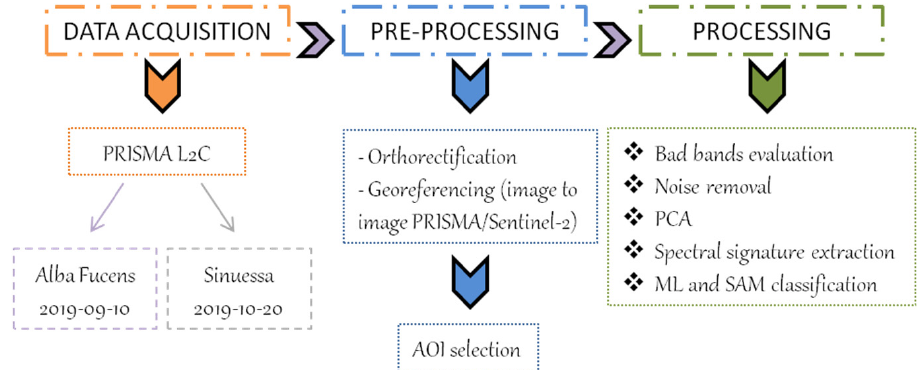
Figure 2. Methodological workflow followed to study capabilities and limits of PRISMA sensor.